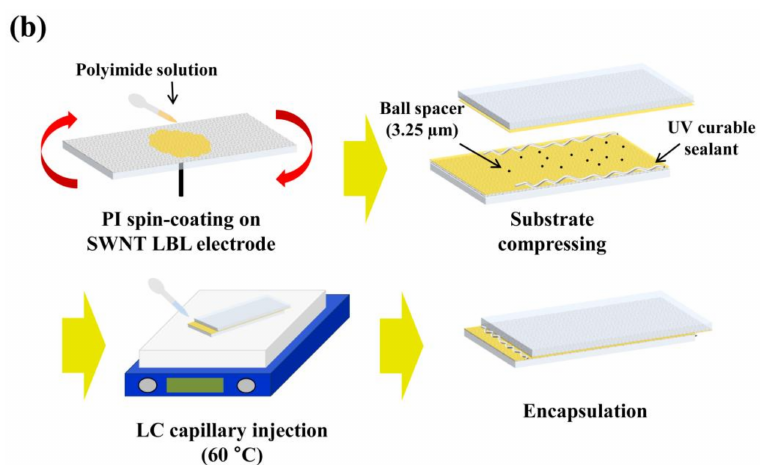
Figure 1. ( a ) Schematic illustration of the layer-by-layer (LBL) dipping process with poly (diallyldimethylammonium chloride) (PDDA) and single-walled carbon nanotube–sodium deoxycholate (SWNT–DOC) aqueous solutions. ( b ) Manufacturing process of liquid crystal display (LCD) using transparent SWNT electrode fabricated by the LBL